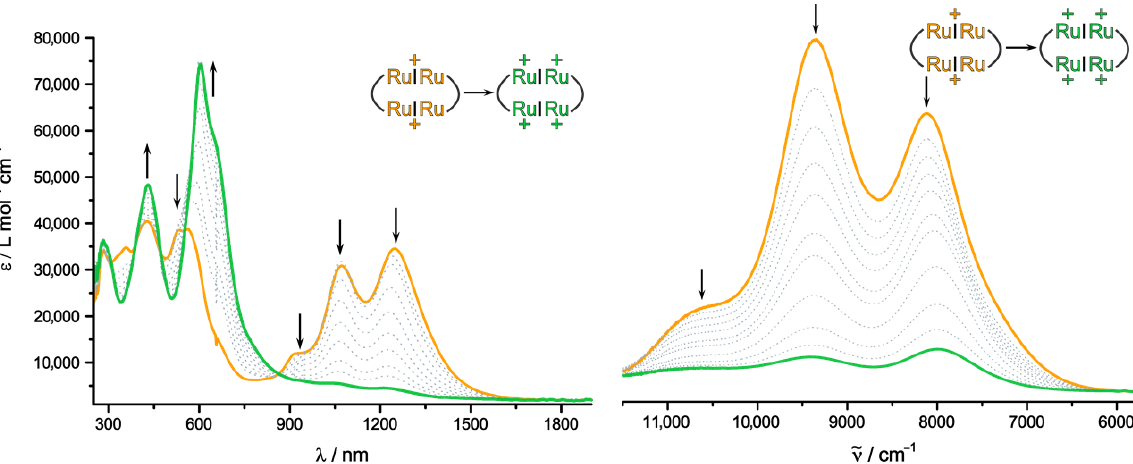
Figure 11. Changes in the UV/Vis/NIR spectrum (DCE, 0.05 M NBu 4 BAr F24 , r.t.) of 2 Ru 2 Ph-Croc during the third/fourth oxidations ( left ) with corresponding excerpt from the IR/NIR range ( right ).